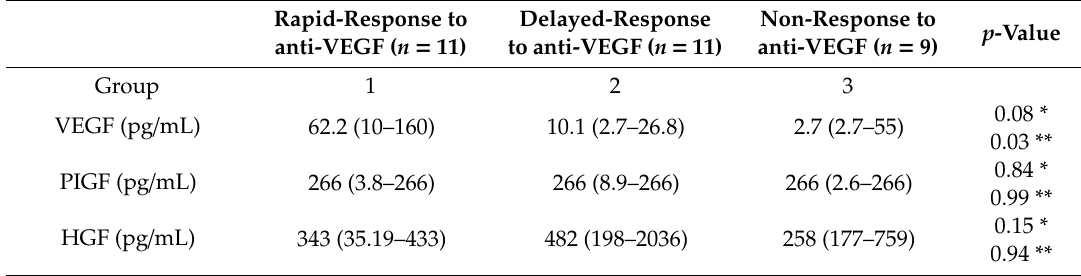
Table 3. Concentration of growth factors and cytokines in aqueous humor (AH) according to anti-VEGF treatment